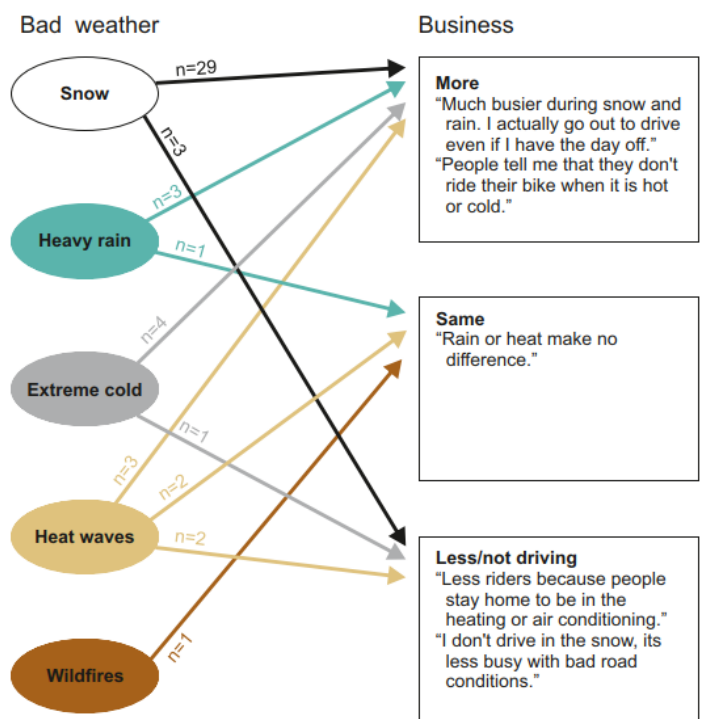
Figure 3. Participants driving for TNC (Transportation Network Company) reporting how their TNC business is affected by different types of extreme weather events. N—number of participants reporting on a specific type of weather event.